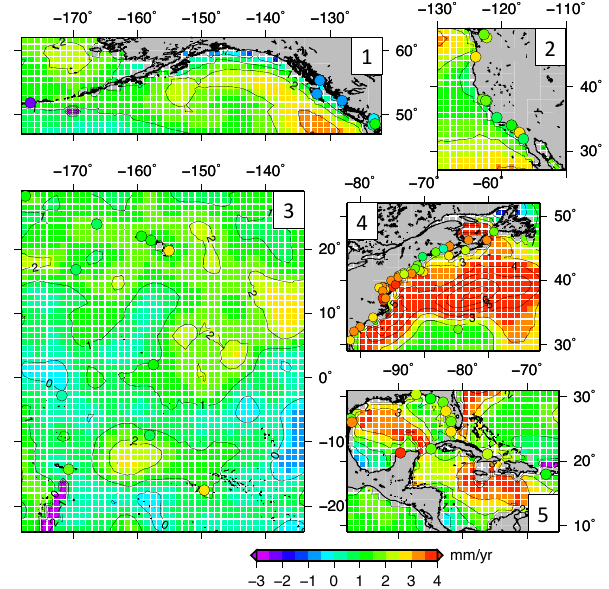
Figure 5. Trends in sea-level change (mmyr − 1 ) over the period 1961–2003, for regions (1) Gulf of Alaska, (2) West coast USA, (3) North Pacific Ocean, (4) East coast USA, and (5) the Caribbean. Zoom of Fig. 4. Regions indicated in Fig.